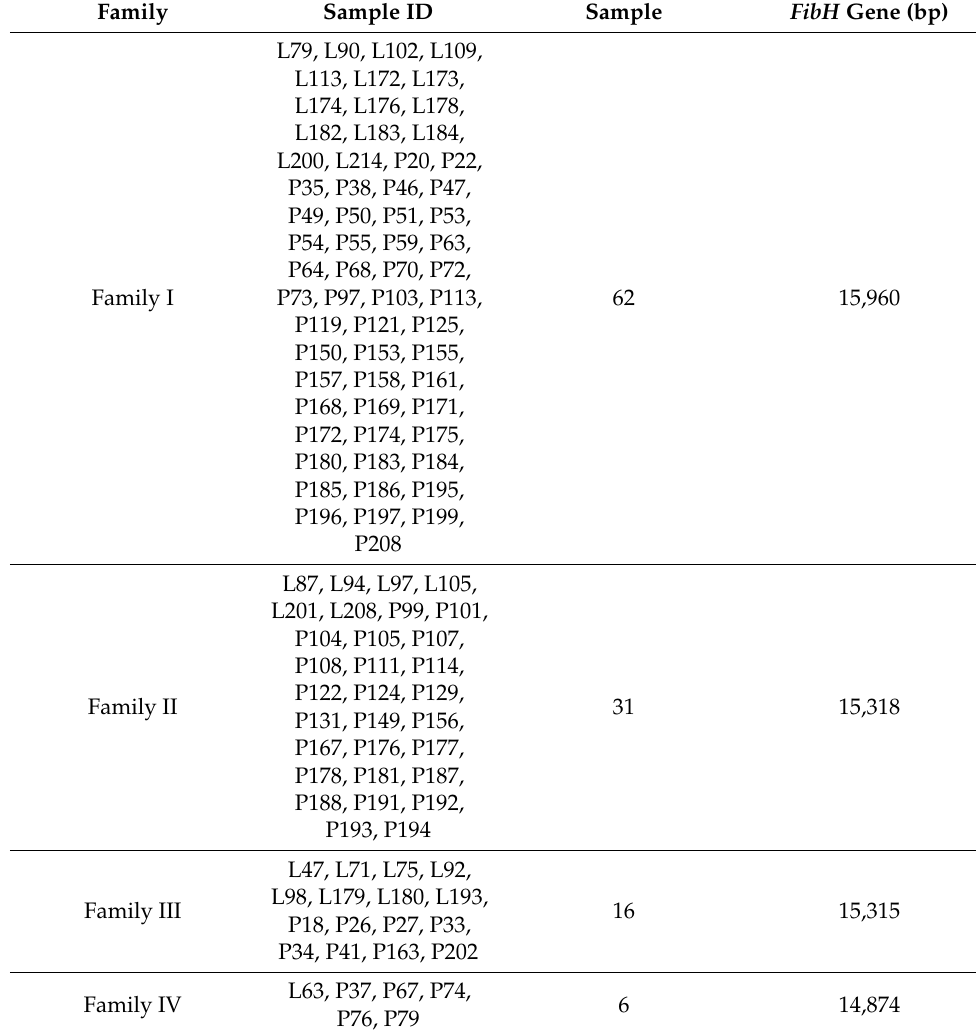
Table 1. Silkworm pedigree with the same FibH